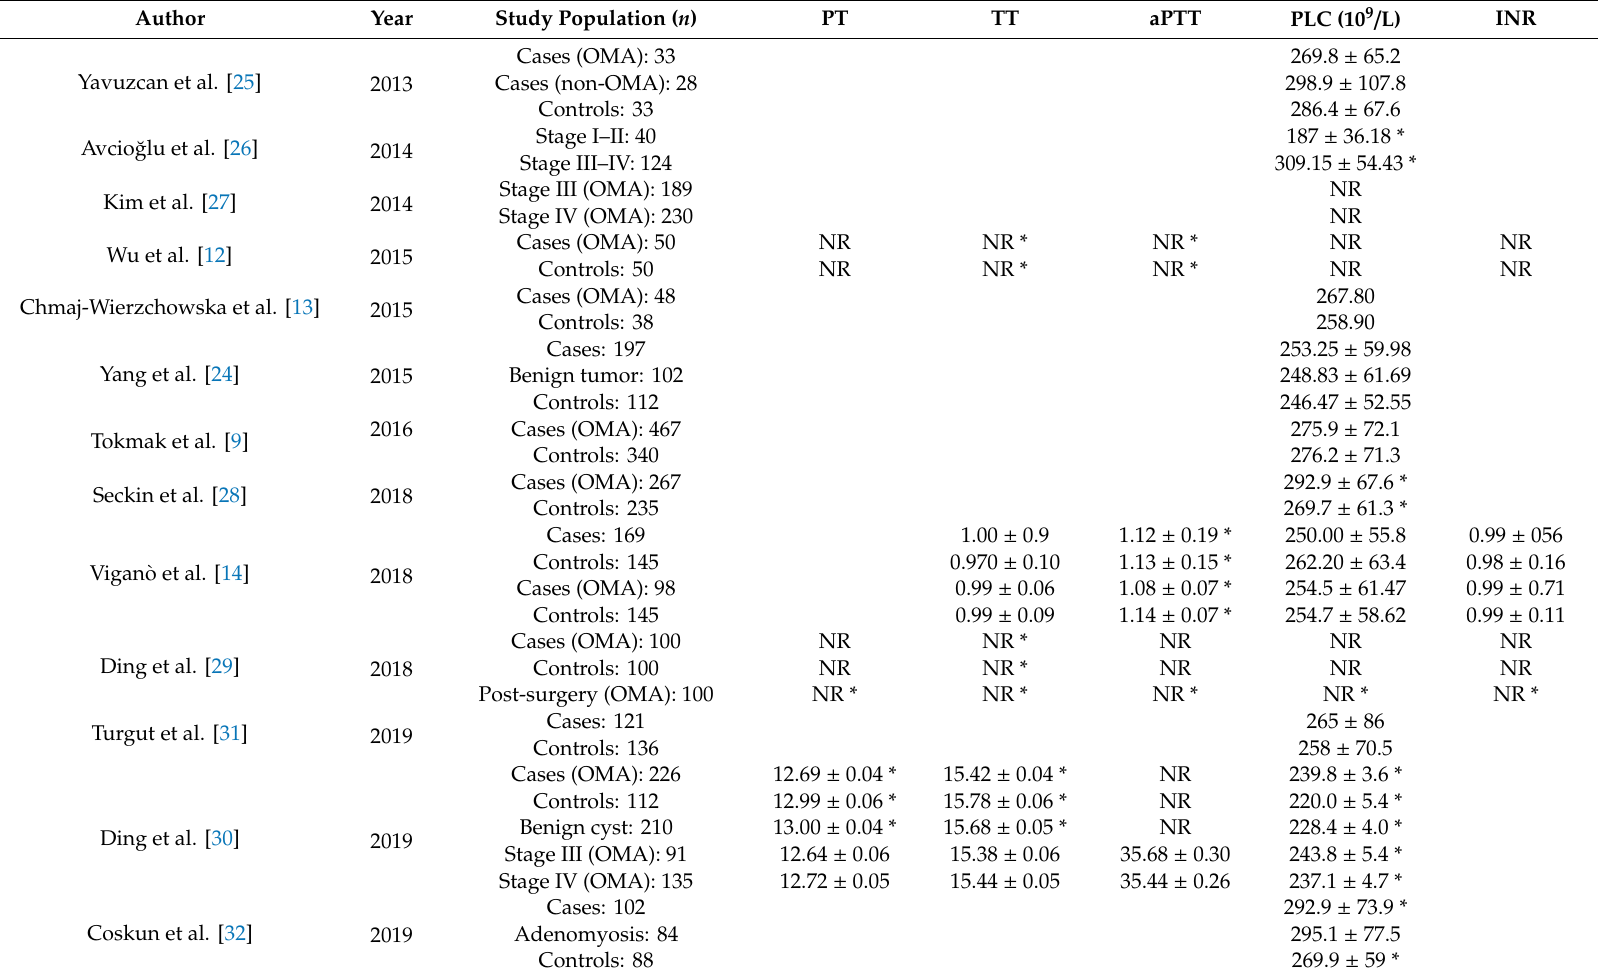
Table 6. Systematic review: coagulation parameters of women with and without endometriosis in the included